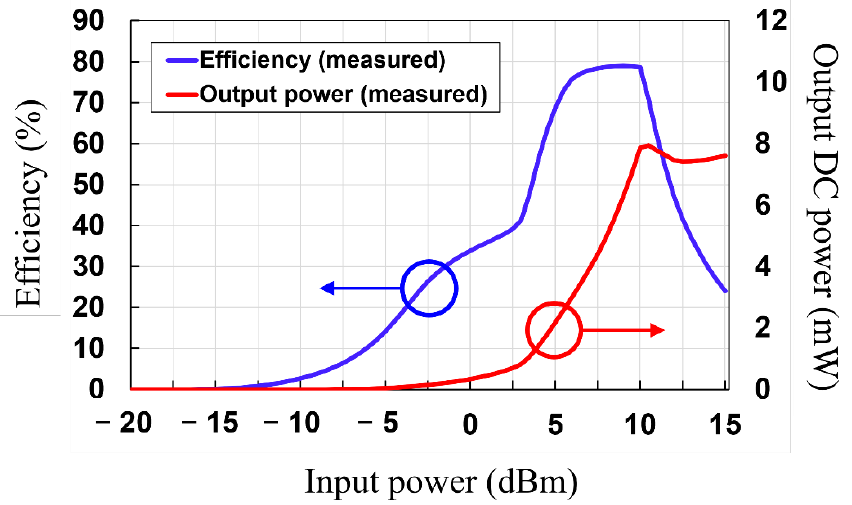
Figure 14. Measured RF – DC conversion efficiency of the MTM-integrated rectenna.